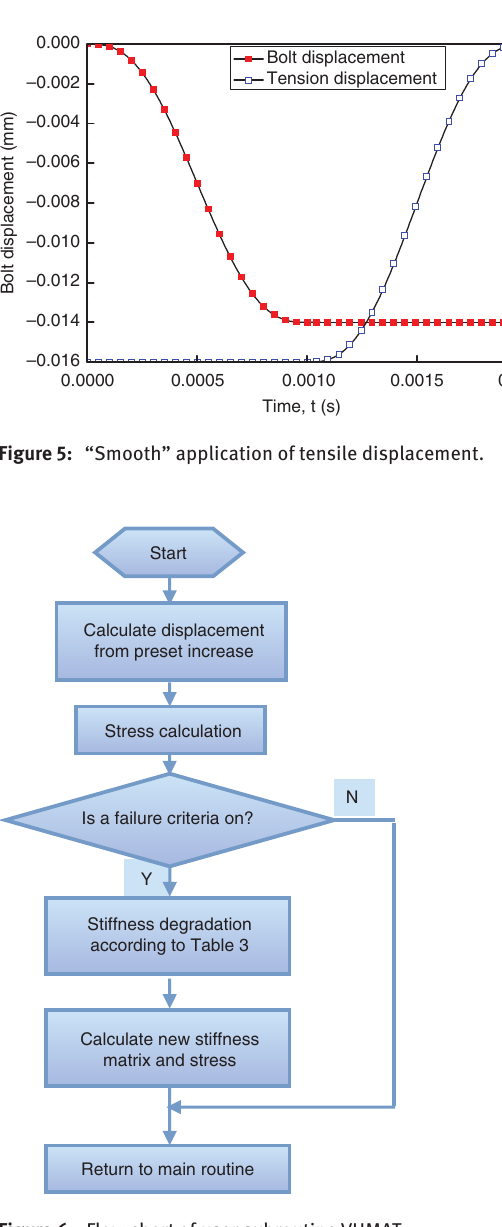
Figure 6: Flow chart of user subroutine VUMAT.